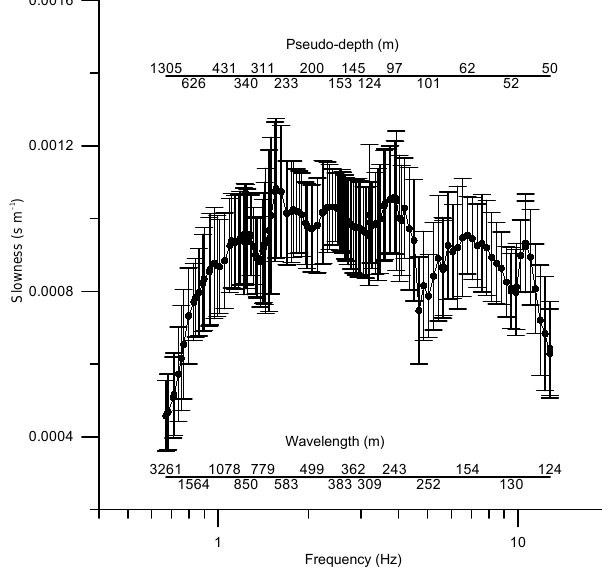
Figure 4. Total dispersion curve for array 1 obtained from the com- bination of the dispersion curves shown in Fig. 3. The correspond- ing wavelength for each slowness and frequency values is indicated in a bottom auxiliary axis as well as the pseudo-depth (top auxiliary axis) calculated as